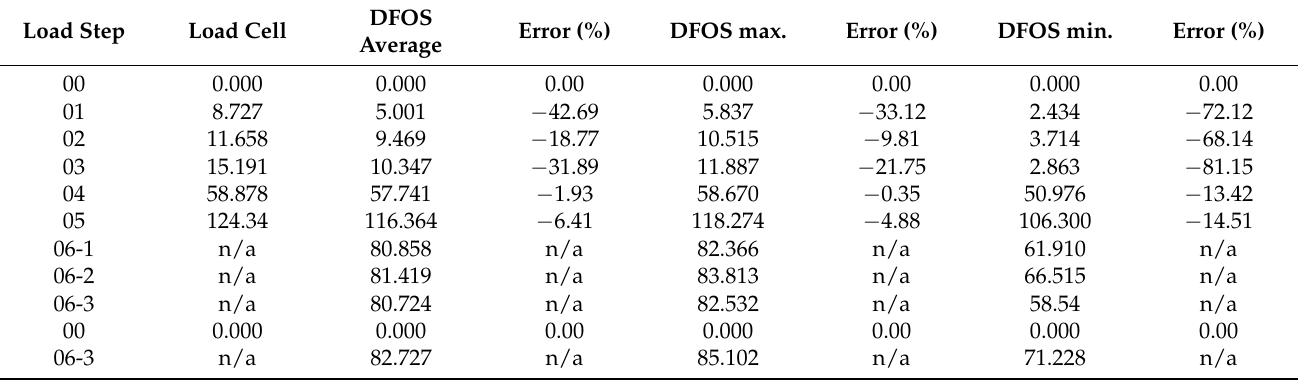
Table 4. Prestressing force monitored by load cell and DFOS for PC1 (unit: kN).